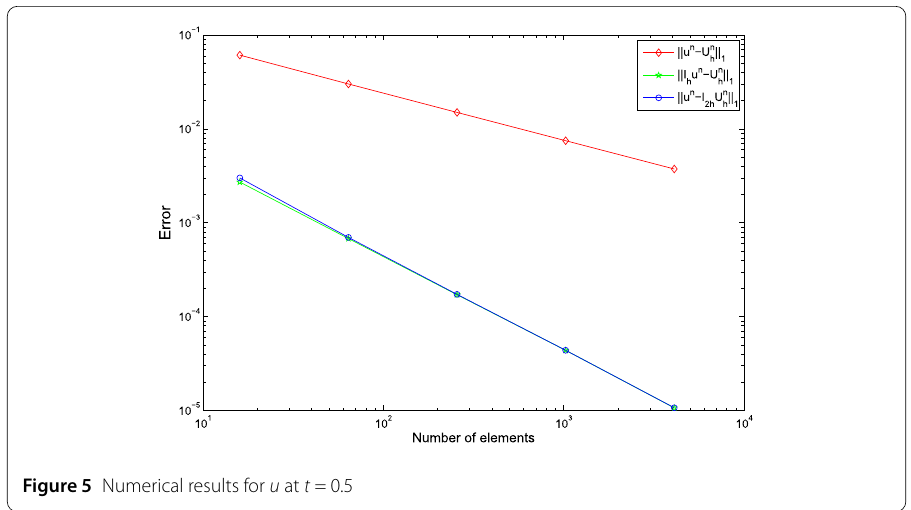
Figure 5 Numerical results for u at t = 0.5